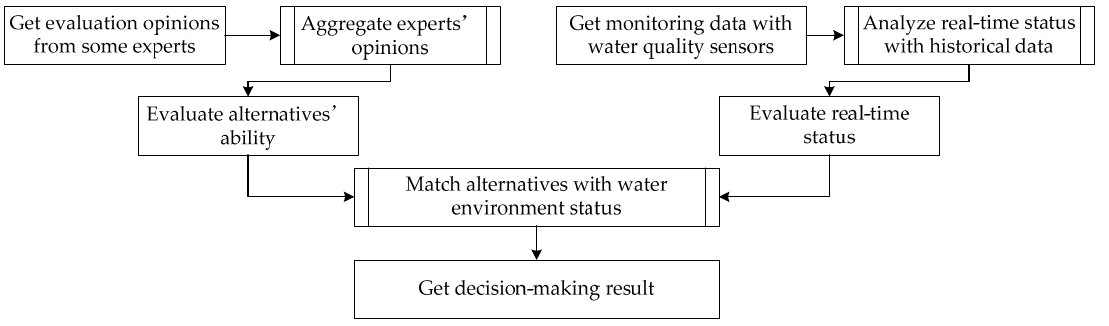
Figure 1. The process of the group decision-making method.